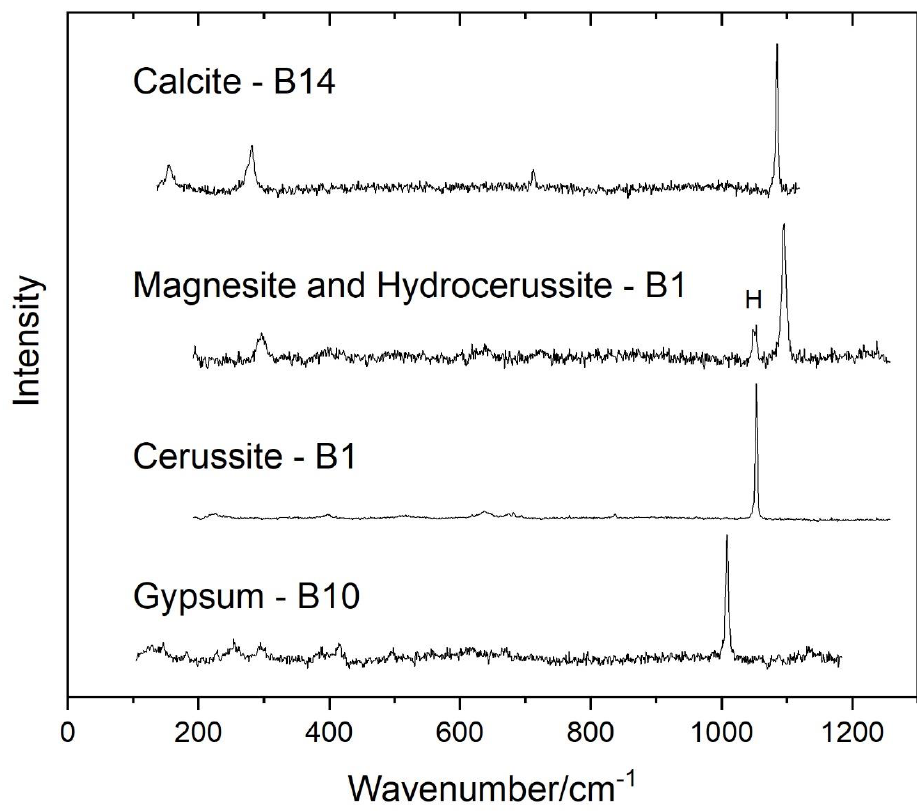
Figure 7. Raman spectra of white pigments. H = hydrocerussite.